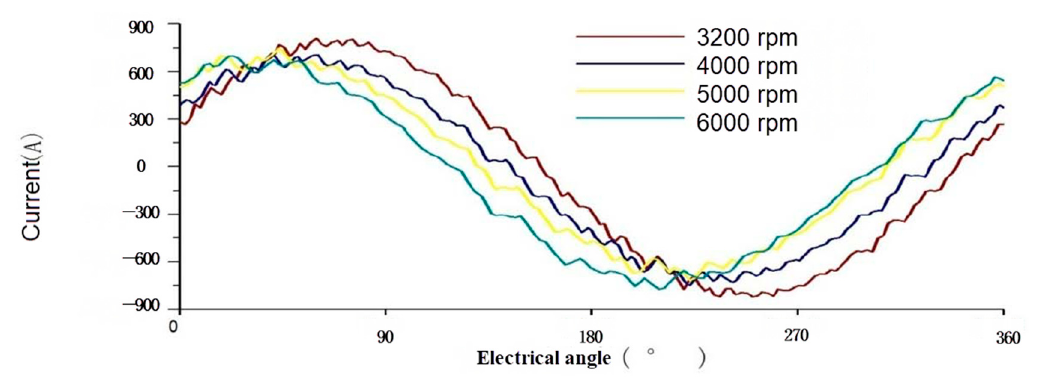
Figure 14. Space vector pulse width modulation (SVPWM) phase A current at different speeds.